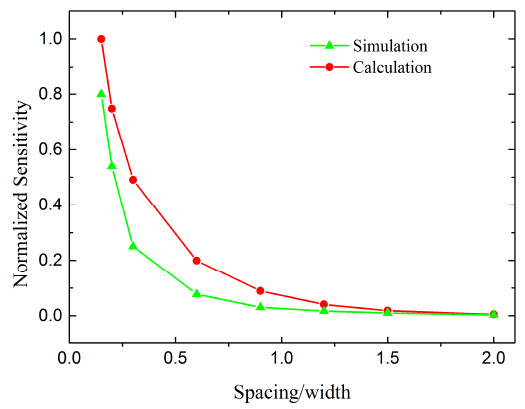
Figure 8. Calculation and Finite Element Modeling (FEM) results for the sensitivity of the transducer considering the fringe effect with different ratios of the capacitor spacing and electrode width ( d / a ).